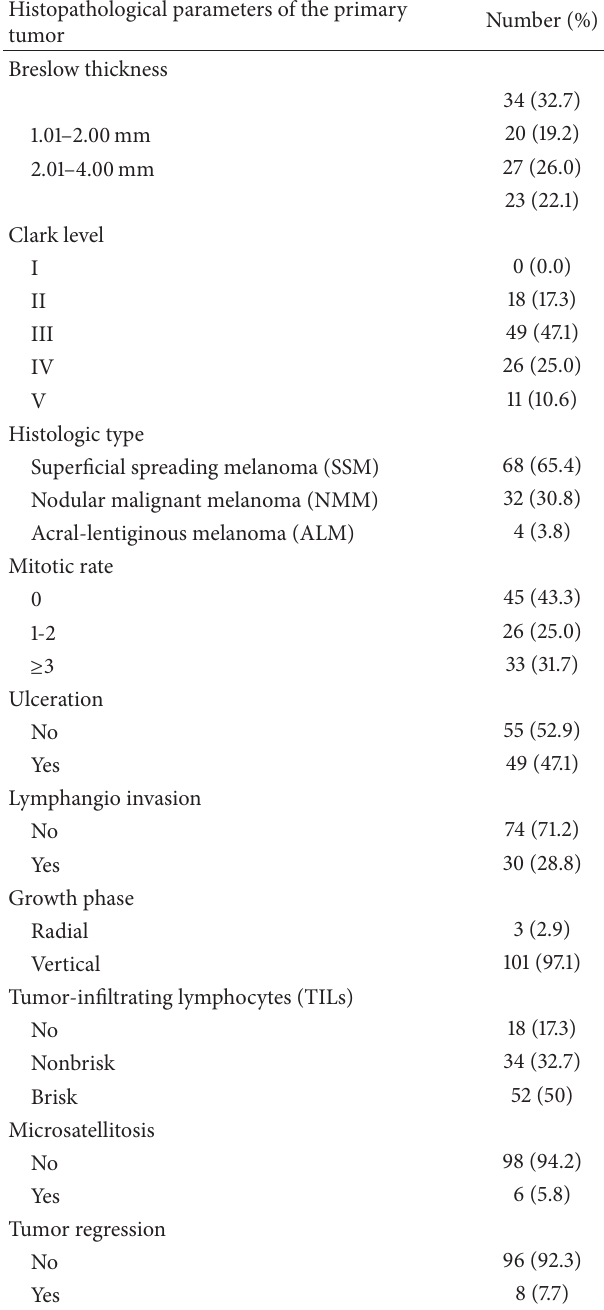
Table 2: Histopathological parameters of primary tumors. Histopathological parameters of the